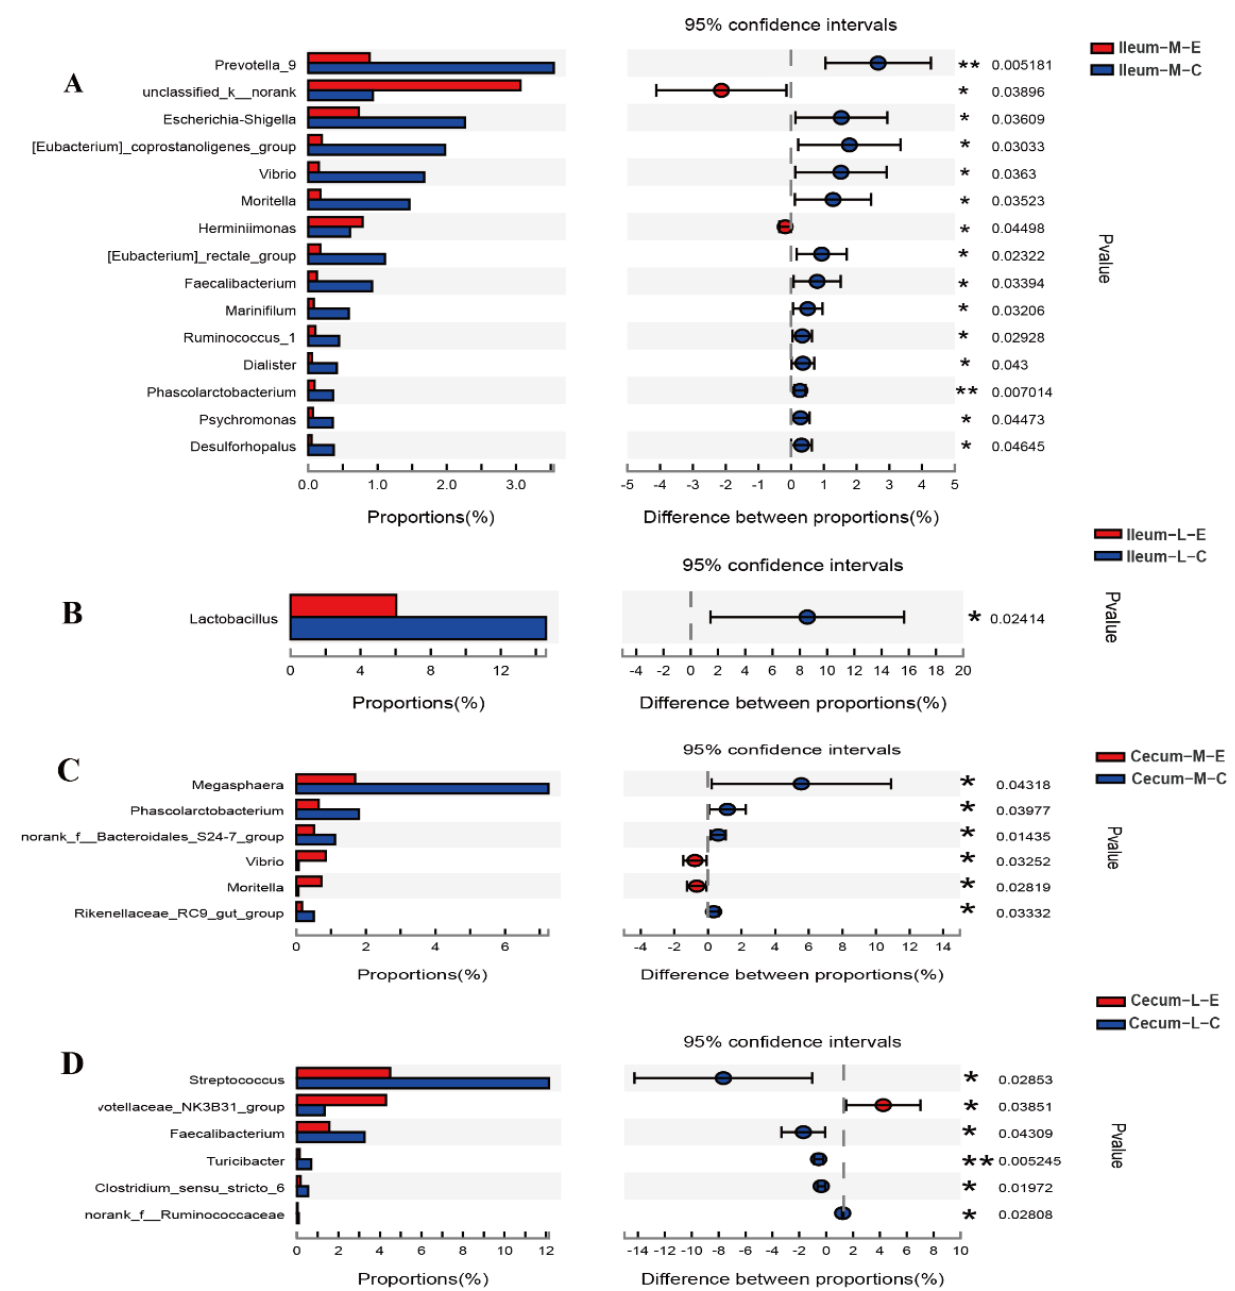
Figure 5. Effects of HDRsEf1 on Microbiota composition in different niches at genus level. ( A ) Ileal mucosal samples at genus level. ( B ) Ileal luminal contents samples at genus level. ( C ) Cecal mucosal samples at genus level. ( D ) Cecal luminal contents samples at genus level. Only relative abundance greater than 0.5% were shown, n = 5 per group, * p < 0.05, ** p < 0.01.